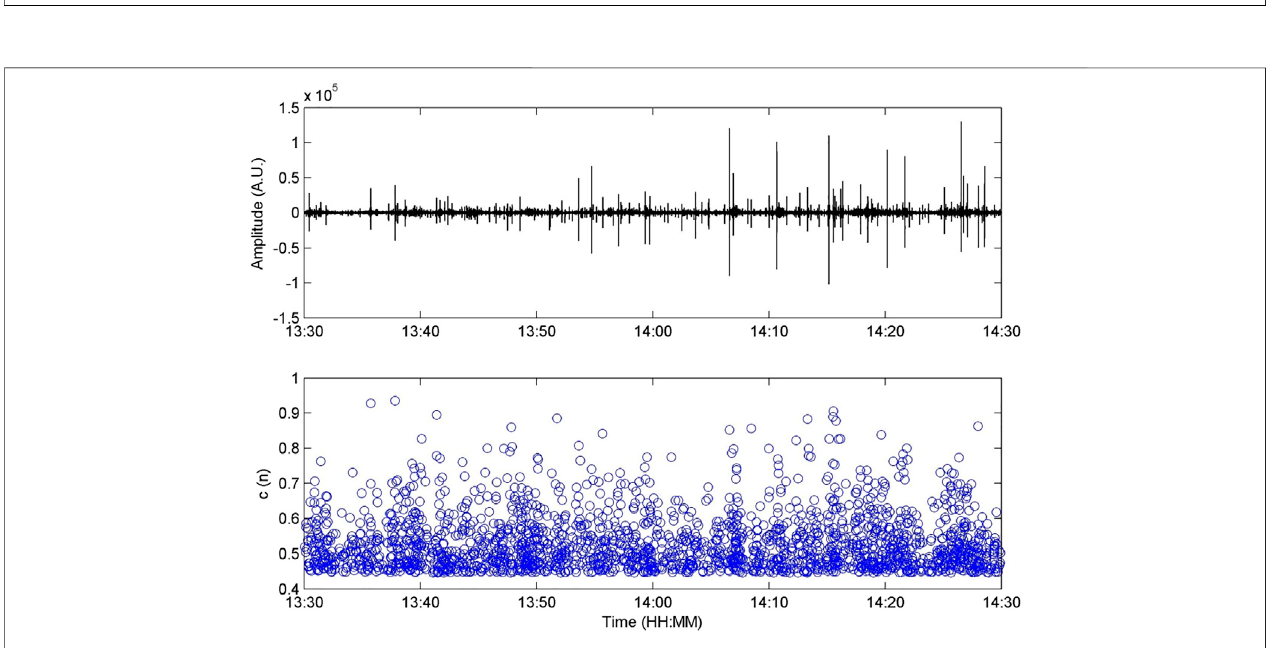
FIGURE6| SignalrecordedatEMFOstationand fi lteredintheband1 – 10 Hz(top)andsubspacedetectionstatisticvalues(c(n))abovetheestimatedthreshold( ɣ ).